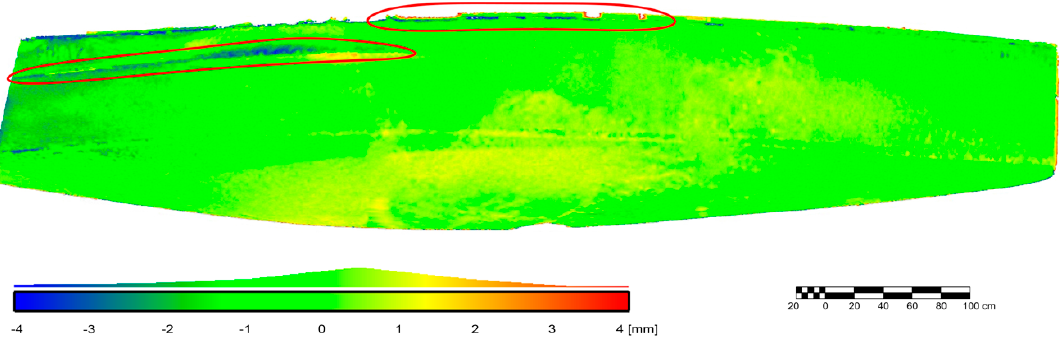
Figure 17. The di ff erence model between terrestrial laser scanning (TLS) and SfM data; with the highest Figure 17. The difference model between terrestrial laser scanning (TLS) and SfM data; with the deviations marked in red highest deviations marked in red areas.